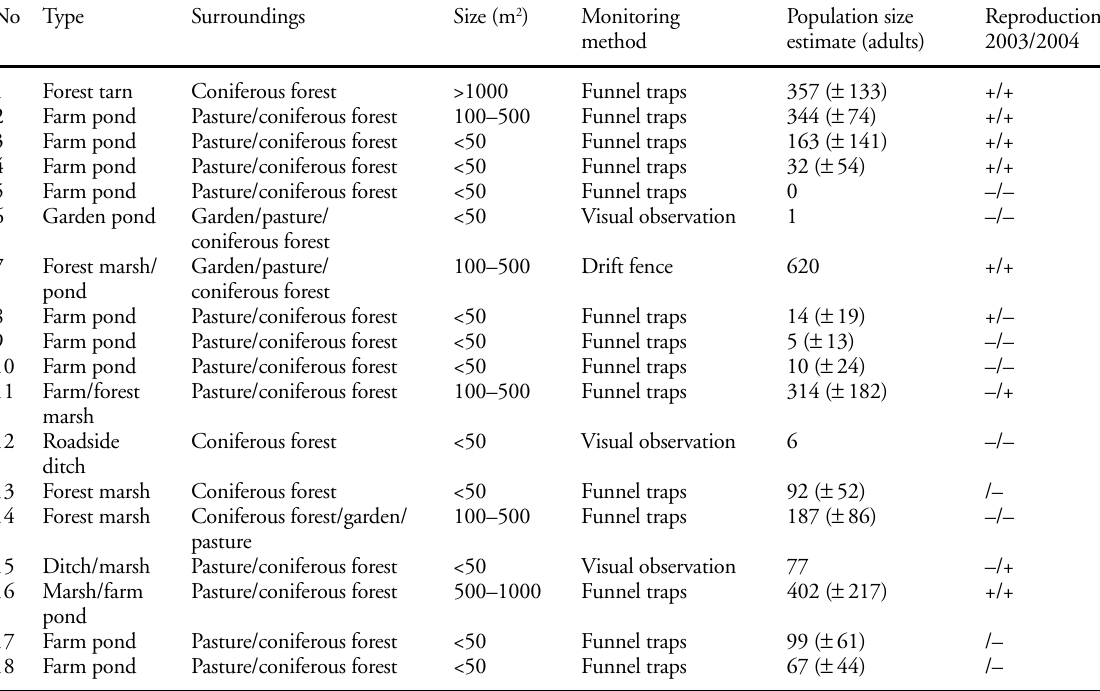
Table 1. Characteristics of monitored ponds with great crested newt, population monitoring method, estimated adult population sizes ( ± SD), and absence (–) or presence (+) of reproduction in 2003 and 2004, respectively. Surroundings are described within a radius of 500 metres from the pond. Reproduction data of 2003 from Karlsson (2003). Ponds 13, 17 and 18 were not monitored for reproduc- tion in